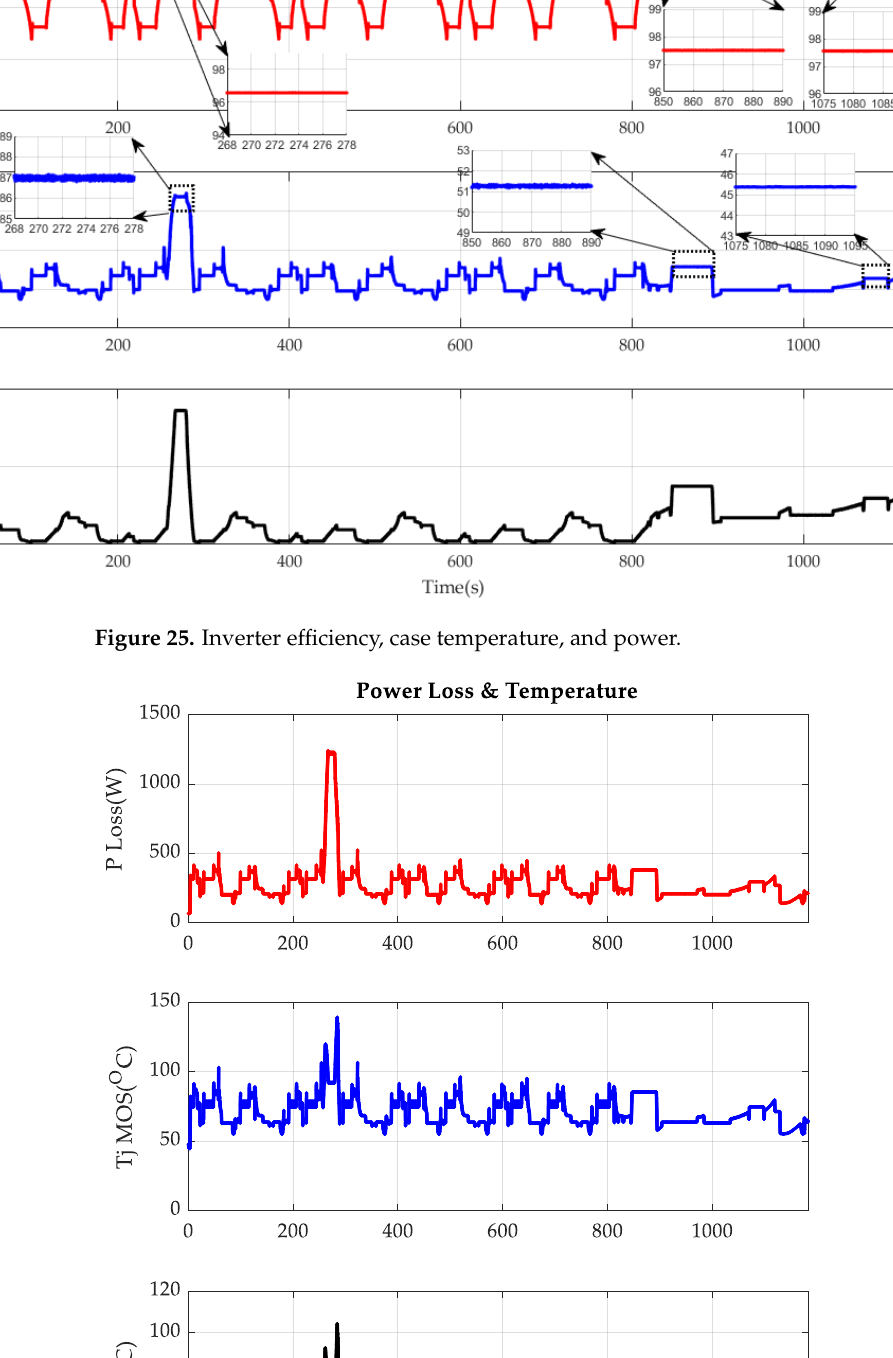
Figure 24. Speed and torque control reference vs. measured.